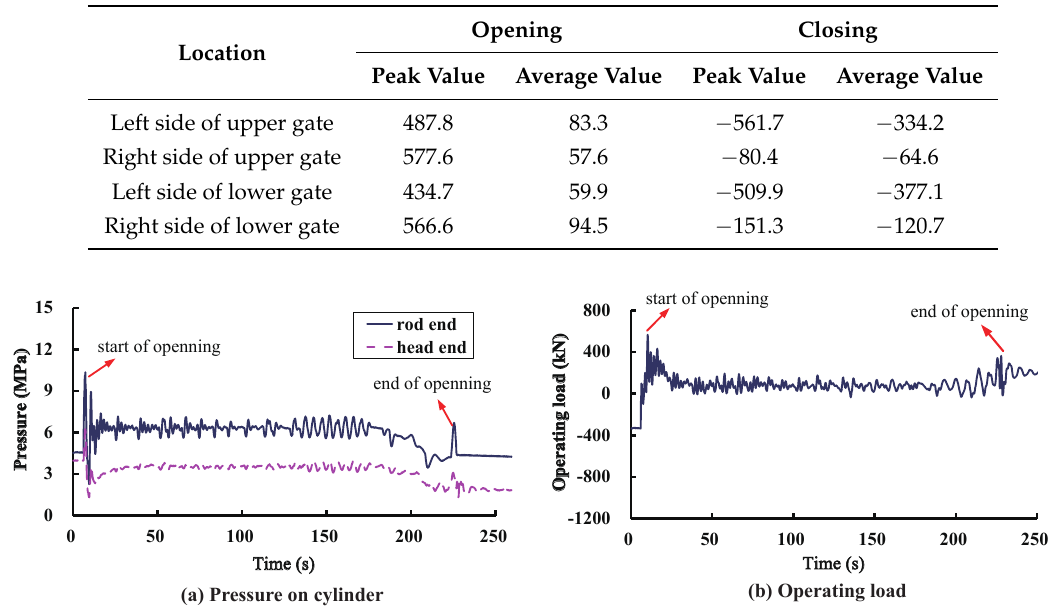
Figure 4. The pressure and operating load during the opening process at the lower lock head.